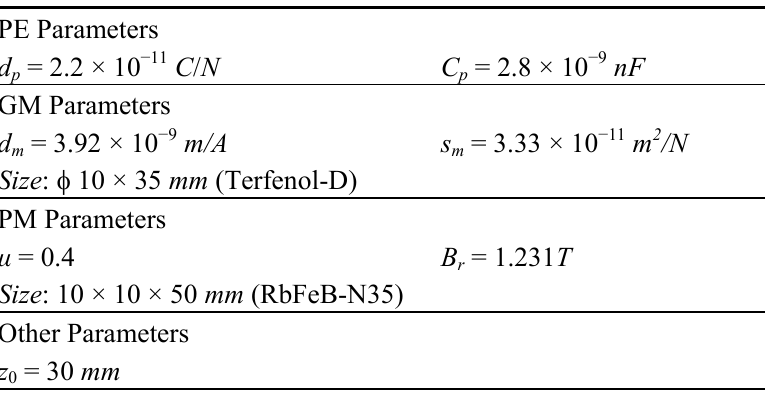
Table 2. The related parameters in theoretical